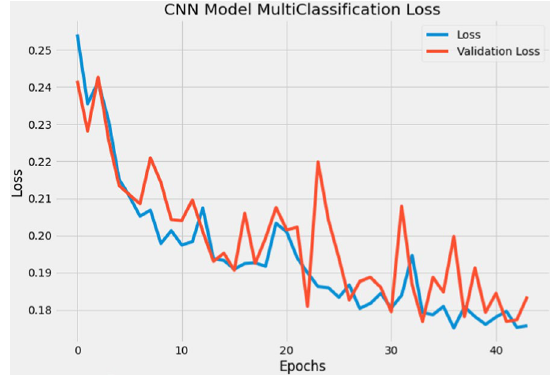
Fig. 14 Training and validation loss of CNN Fig. 15 Training and validation accuracy of LSTM